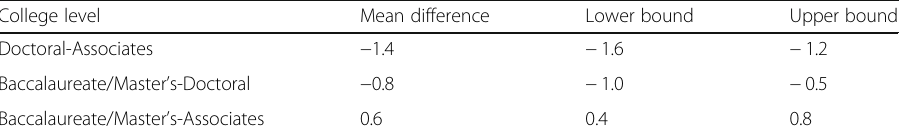
Table 5 Mean differences between Associate ’ s, Baccalaureate, Master ’ s and Doctoral colleges and confidence intervals